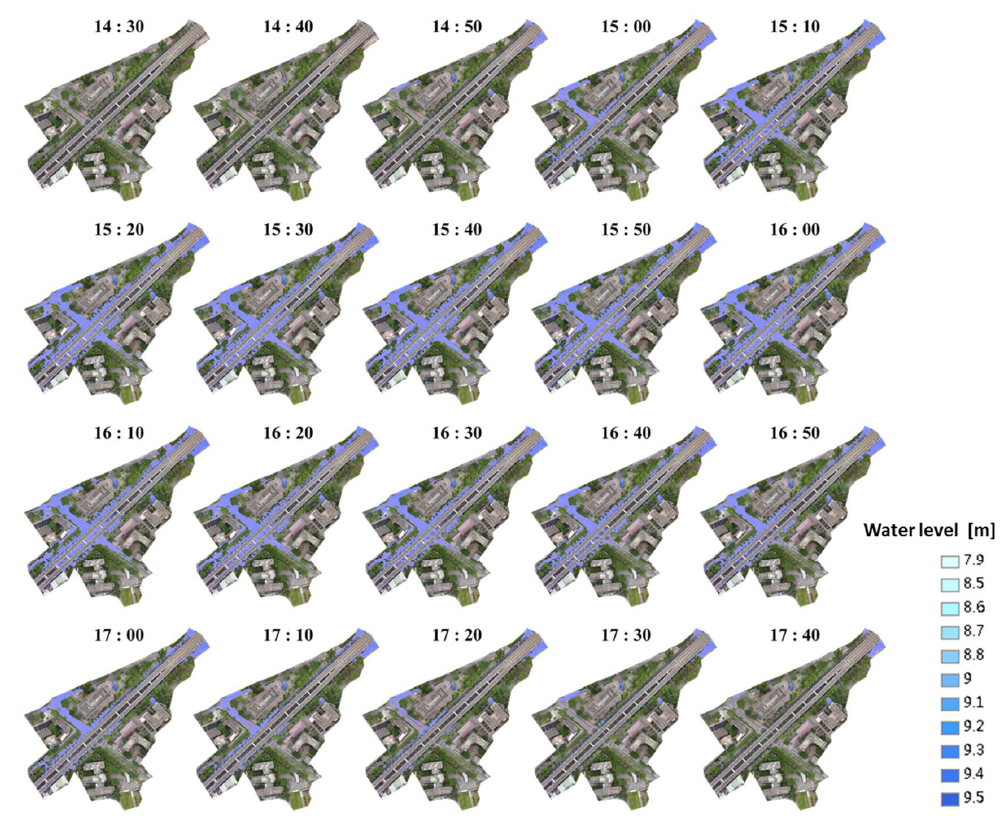
Figure 8. Serial illustration of the simulated flooding area from 14:30 to 17:40.